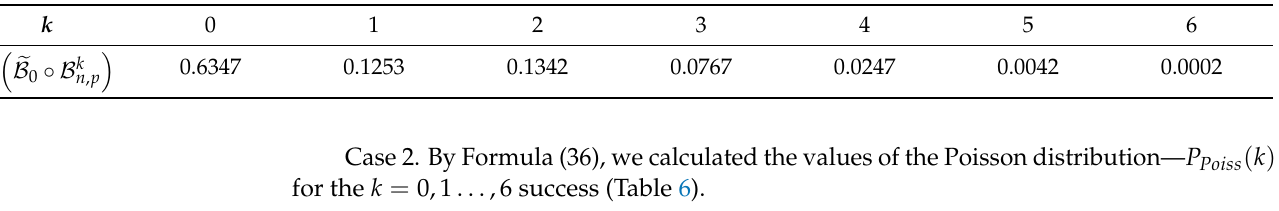
Table 5. The values of probabilities of the fuzzy “upper” BD (cid:101) B 0 ◦ B k n ; p .